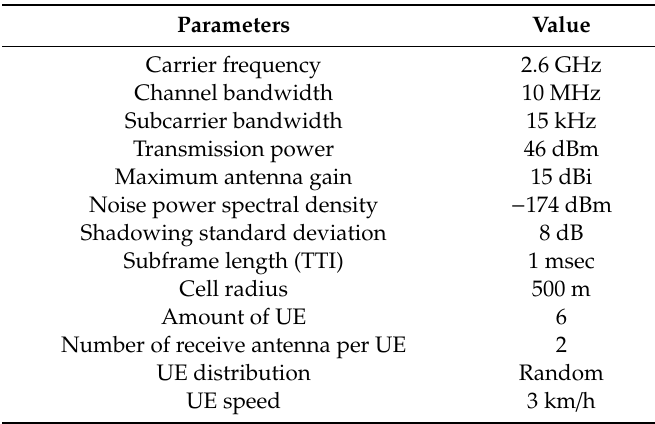
Figure 2. The four considered scenarios. Table 1. Parameters.